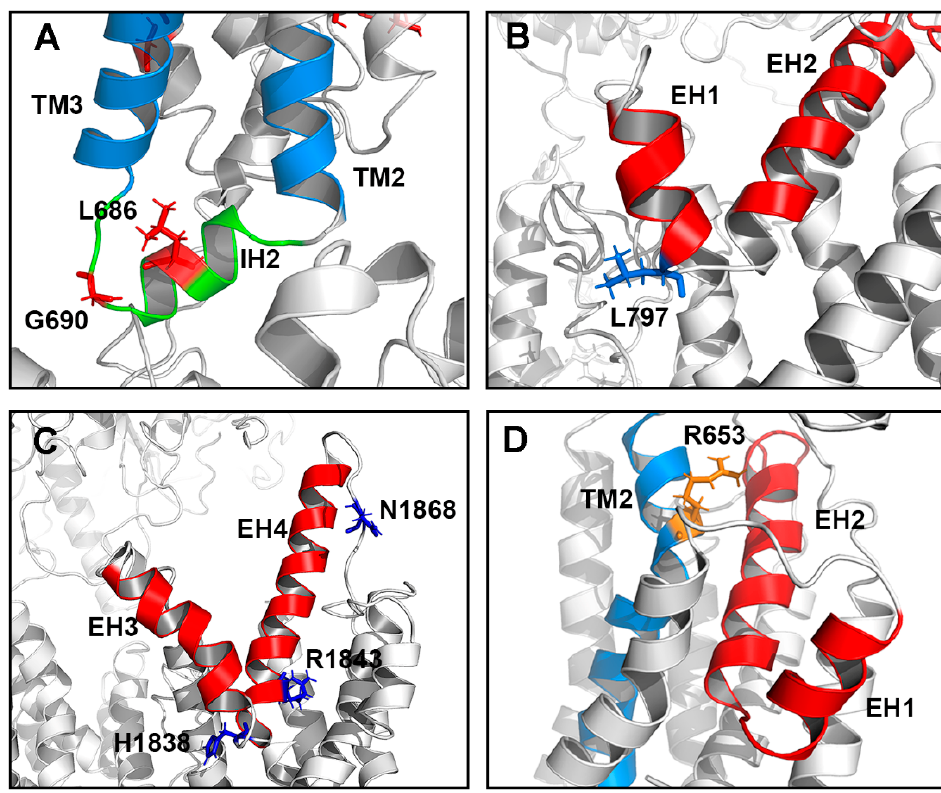
Figure 9. Location of selected amino acid residues in the ABCA4 I-Tasser homology model that, when mutated, cause STGD1. ( A ) The loop region between TM2 and TM3 (blue) showing the intracellular transverse helix IH2 (green) with residues L686 and G690. ABCA4 variants shown as sticks. p.L686S and p.G690V variants cause severe protein misfolding and are predicted to cause severe STGD1 in trans with a null ABCA4 allele. ( B ) The EH1 and EH2 helices (red) between TM5 and TM6 within TMD1 and showing the location of the L797 residue. The ABCA4 variant p.L797P causes significant protein misfolding and is predicted to cause severe STGD1 in trans with a null ABCA4 allele. ( C ) The EH3 and EH4 helices (red) between TM11 and TM12 within TMD2 and showing the H1838, R1843, and N1868 residues. ABCA4 variants p.H1838D, p.H1838N, p.H1838R, and p.H1838Y are predicted to cause moderate or severe STGD1 (see Table 2) in trans with a null ABCA4 allele. The p.R1843W variant is predicted to cause moderate STGD1 in trans with a null ABCA4 allele. The p.N1868I variant in the loop between EH4 and TM12 is predicted to cause a mild STGD1 phenotype based on func- tional assays. ( D ) Location of R653 within TM2. This residue is suggested to comprise part of the binding site for N -Ret- PE substrate based on biochemical studies. TM2 (blue); EH1 and EH2